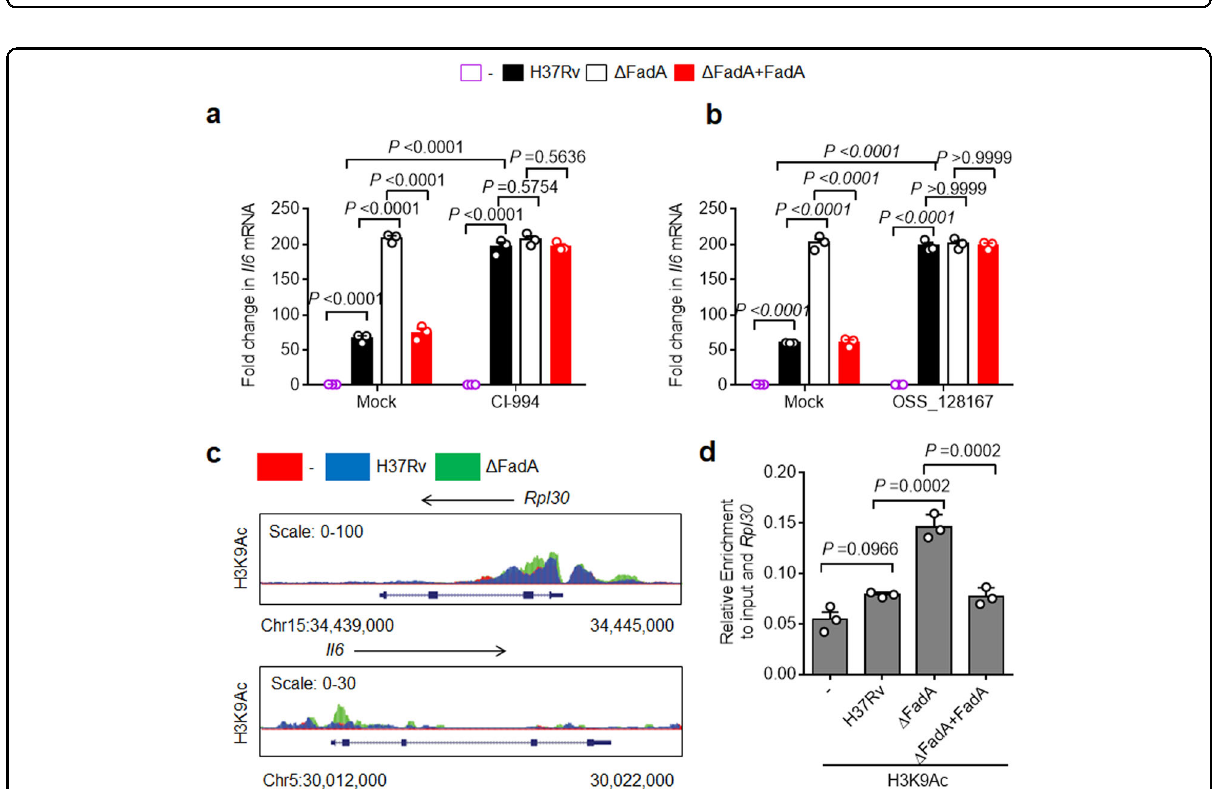
Fig. 4 FadA suppresses IL-6 through H3K9Ac. a qPCR analysis of Il6 mRNA from control or histone deacetylase (HDAC) 1 – 3 inhibitor CI-994- pretreated peritoneal macrophages infected with H37Rv, H37Rv Δ FadA, or H37Rv( Δ FadA + FadA) strains for 4 h (MOI = 1) (mean ± SEM). b qPCR analysis of Il6 mRNA from control or OSS_128167, a selective inhibitor that increases the acetylation of H3K9-pretreated peritoneal macrophages infected with H37Rv, H37Rv Δ FadA, or H37Rv( Δ FadA + FadA) strains for 4 h (MOI = 1) (mean ± SEM). c ChIP-seq analysis of histone H3 acetylation at the lysine 9 residue (H3K9Ac) for the Il6 promoter of peritoneal macrophage infected with H37Rv or H37Rv Δ FadA strains for 4 h (MOI = 1) with SimpleChIP Enzymatic Chromatin IP Kit. d ChIP-qPCR (mean± SEM) analysis of H3K9Ac for the Il6 promoter of peritoneal macrophage infected with negative control, H37Rv, H37Rv Δ FadA, or H37Rv( Δ FadA + FadA) strains for 4 h (MOI = 1). Data in a , b , d represent one experiment with at least three independent replicates. One-way ( d ) or two-way ( a , b ) ANOVA with Bonferroni ’ s multiple comparisons test were used for statistical